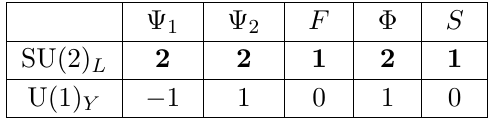
Table 1 . Field content of the scotogenic model T1-2A in addition to the Standard Model fields. singlet-doublet scalar [24–27] and singlet-doublet fermion [24, 25, 28–31] extensions.